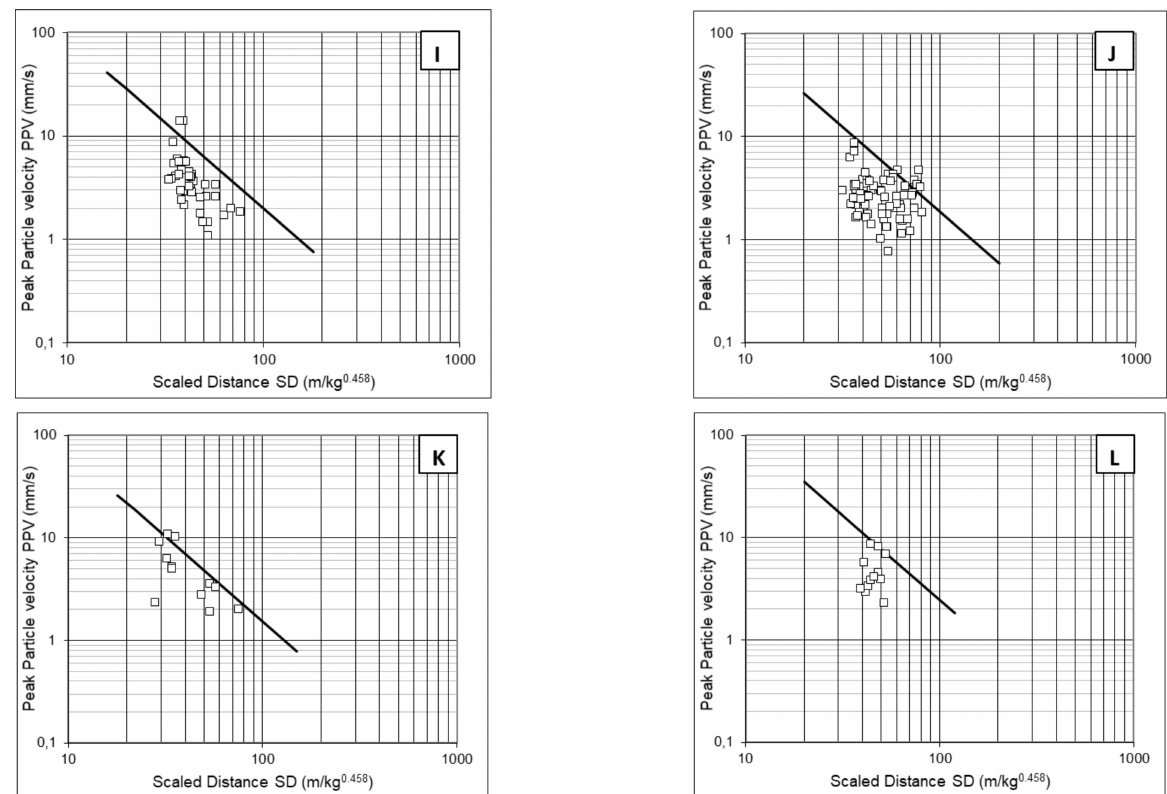
Figure 8. PPV-SD results from the 12 control